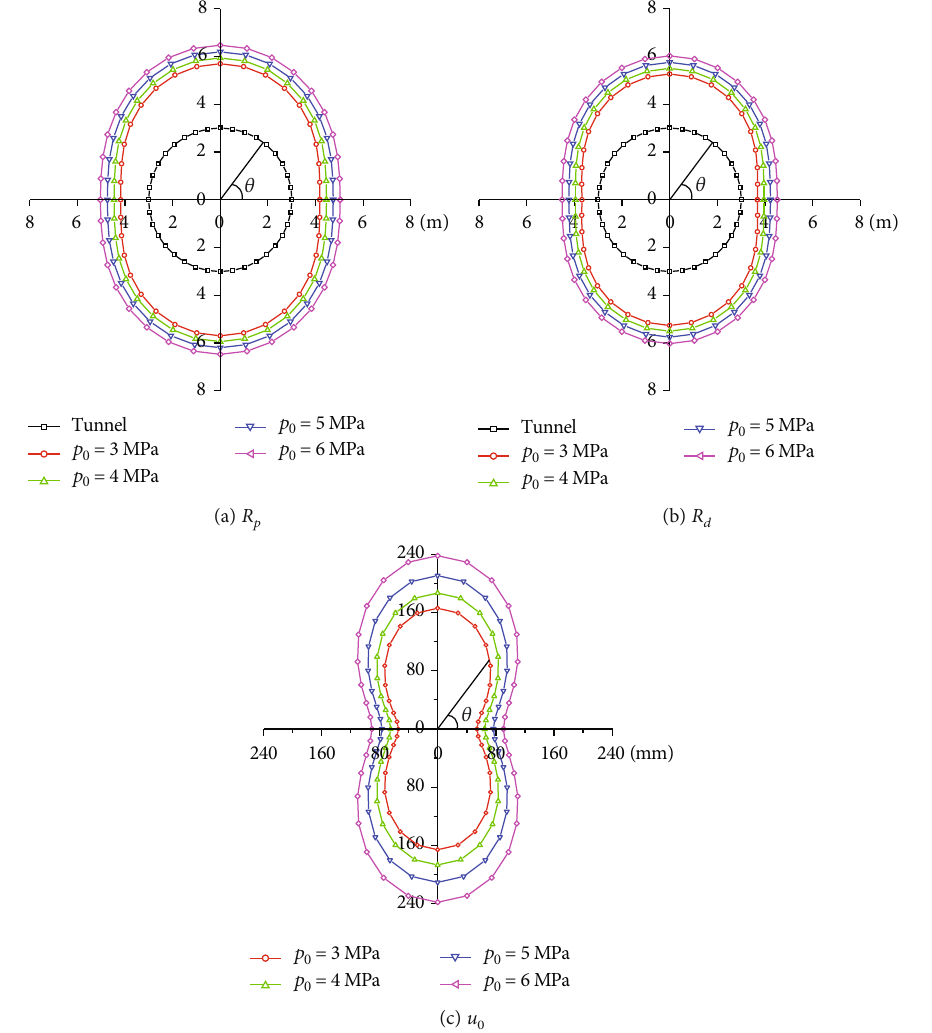
Figure 5: Postpeak zone radii and surface displacement around the tunnel under di ff erent pore water pressures.